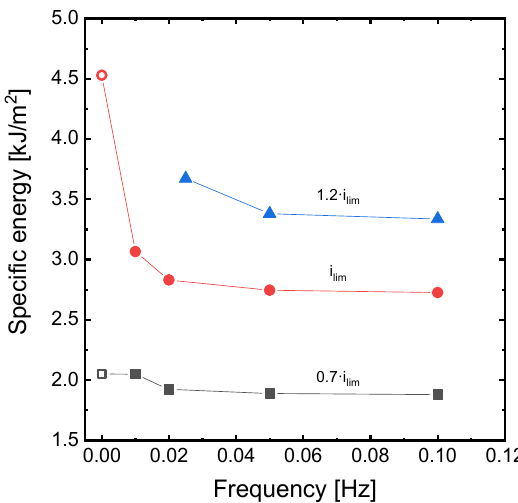
Figure 7. Effect of frequency of PEF implementation on the specific energy consumption at different levels of current density and duty cycle α = 0.5. Empty symbols represent the operation in continuous mode.